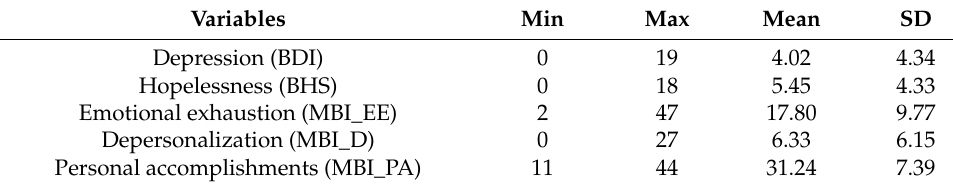
Table 2. Mean scores for hopelessness, depression, and burnout scales. Variables Min Max